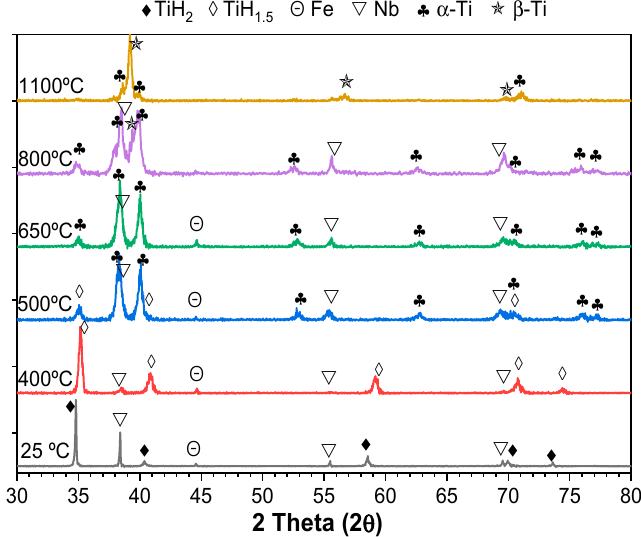
Figure 8. X-ray diffractograms showing the evolution of phases’ transformations as function of Figure 8. X-ray di ff ractograms showing the evolution of phases’ transformations as function of temperature by TiH 2 -5Fe25Nb (from room temperature to 1100 °C). temperature by TiH 2 -5Fe25Nb (from room temperature to 1100 ◦